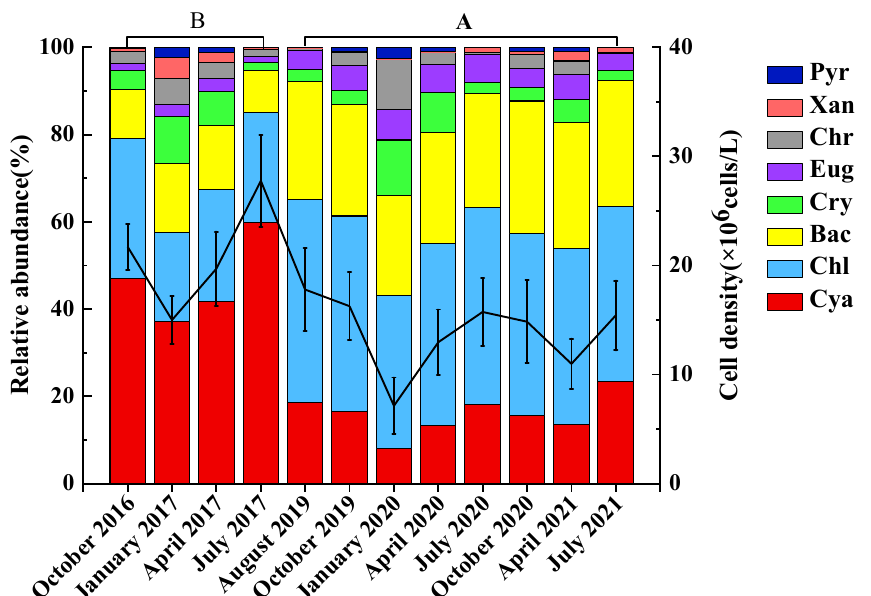
Figure 4. Temporal variation of phytoplankton cell density before and after aquatic vegetation restoration. The left axis or bar graph indicated the relative abundance of phytoplankton cell density, and the right axis or dark line indicated the average cell density (average and standard deviation) of all points at each sampling date in Caizi Lakes. Abbreviations was used in the diagram: Pyr: Pyrrophyta, Xan: Xanthophyta, Chr: Chrysophyta, Eug: Euglenophyta, Cry: Cryptophyta, Bac: Bacillariophyta, Chl: Chlorophyta, Cya: Cyanobacteria. Capital letters B and A indicated before and after aquatic plant restoration, respectively.